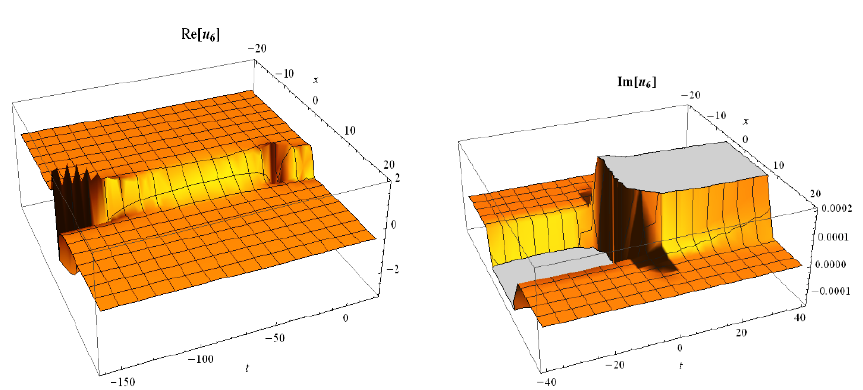
Figure 13. Three-dimensional graphs of imaginary and real part of (34).